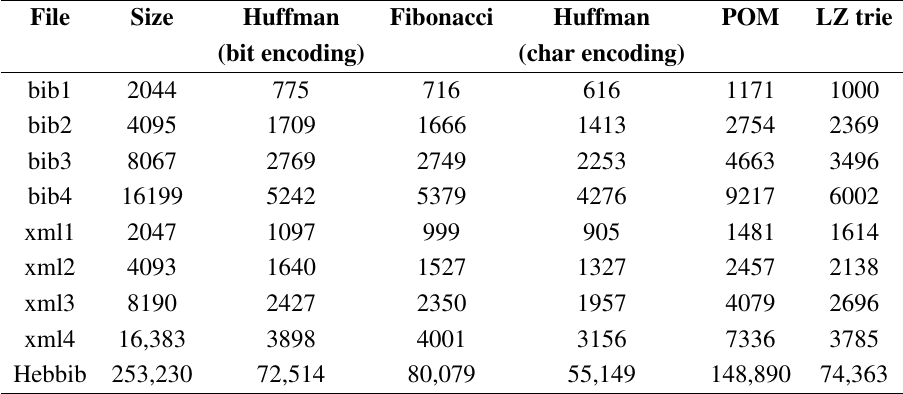
Table 4. Comparative chart of compression